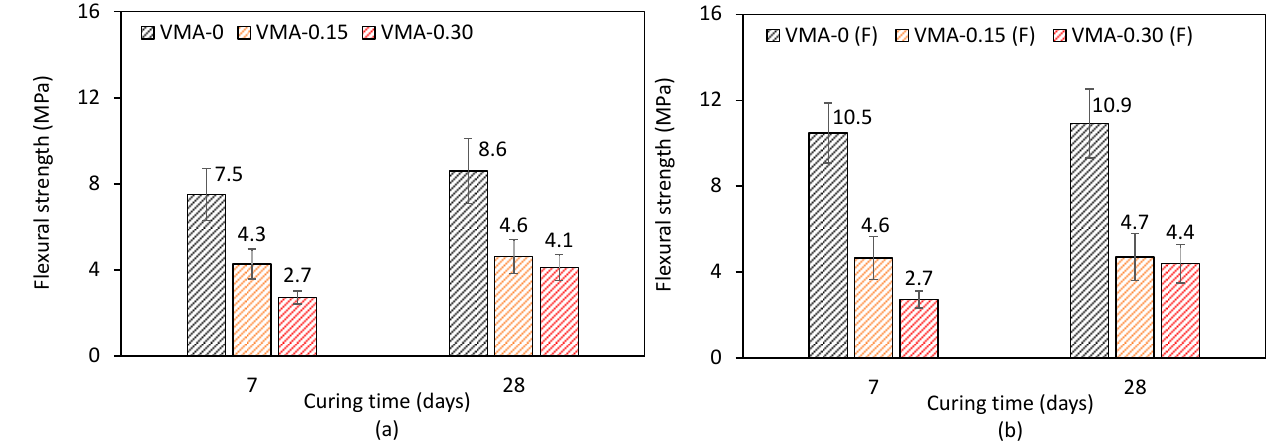
Figure 15. Flexural strengths of the extruded specimens for fiber-free ( a ) and fiber-reinforced ( b ) mixtures.